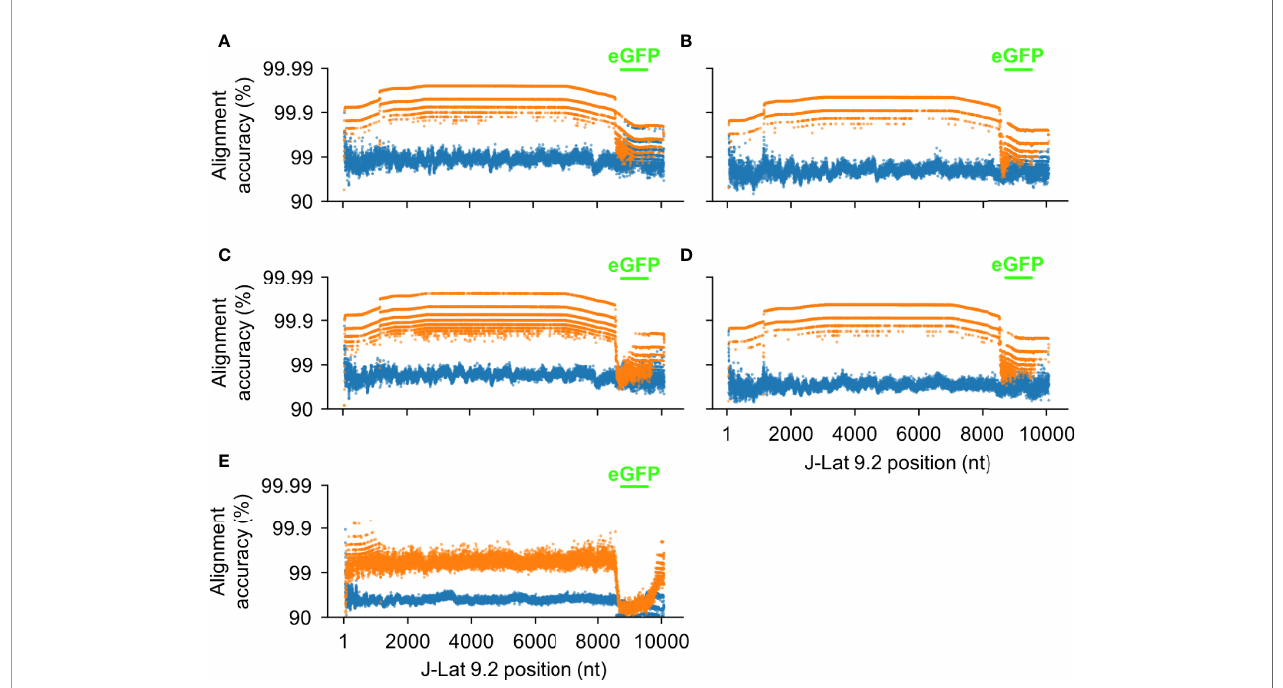
FIGURE 11 | HIV-Quasipore improved read quality across the unseen J-Lat 9.2 genome. Each point represents the average alignment accuracy from reads overlapping a position within the J-Lat 9.2 reference genome for (A) R9.4.1 SUP, (B) R10.3 SUP, (C) R9.4.1 HAC, (D) R10.3 HAC, and (E) R9.4.1 fast pretrained and HIV-Quasipore basecallers. Orange points represent HIV-Quasipore basecallers while blue points represent their pretrained counterparts. Positions encompassing the mapped eGFP region within the J-Lat 9.2 genome are signi fi ed by green dashes.